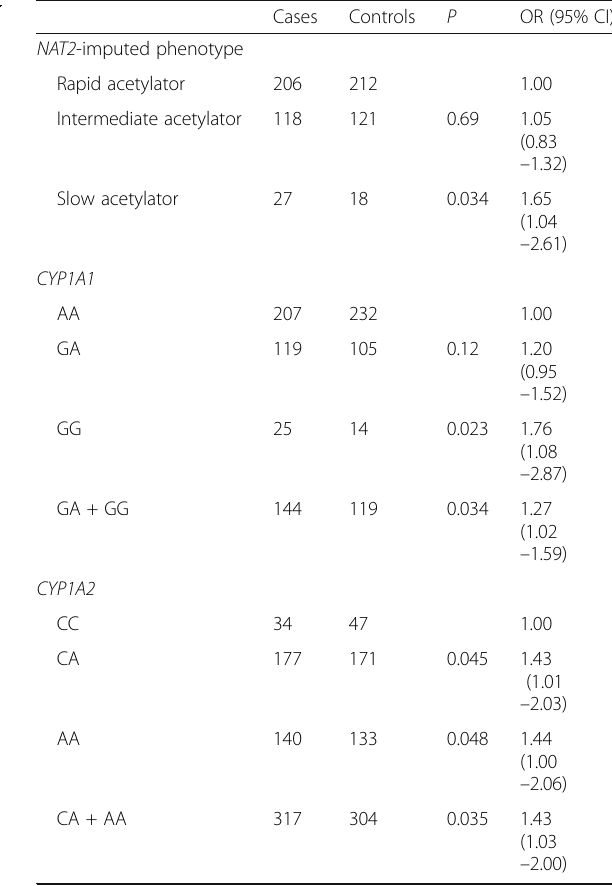
Table 3 Association between HAA intake and prostate cancer Table 4 Association between NAT2 -imputed phenotype, CYP1A1 and CYP1A2 genotype, and prostate